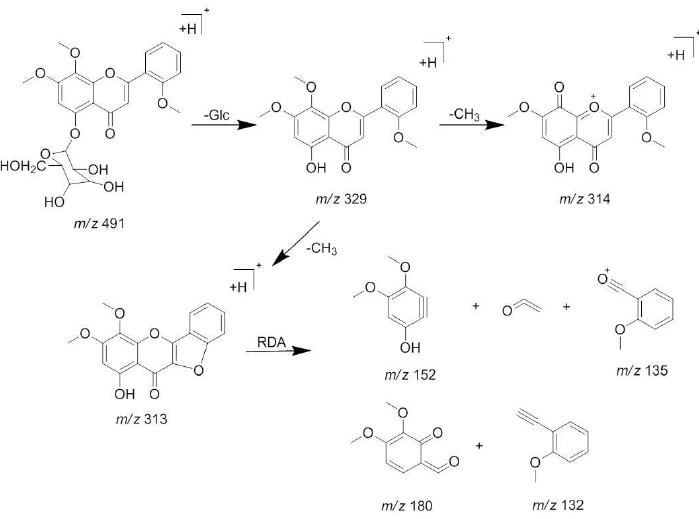
Figure 3. MS/MS spectra of andrographidine E ( 1 ).